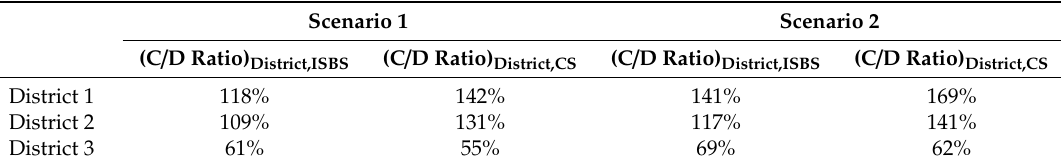
Table 3. C/D ratios with various sharing strategies under Scenario 1 and Scenario 2.